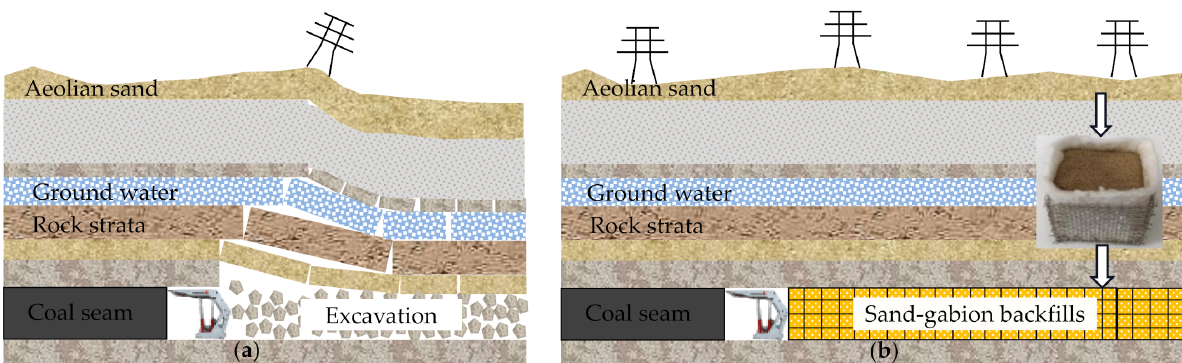
Figure 2. Overburden movement of underground coal mining; ( a ) without backfills; ( b ) with sand- gabion